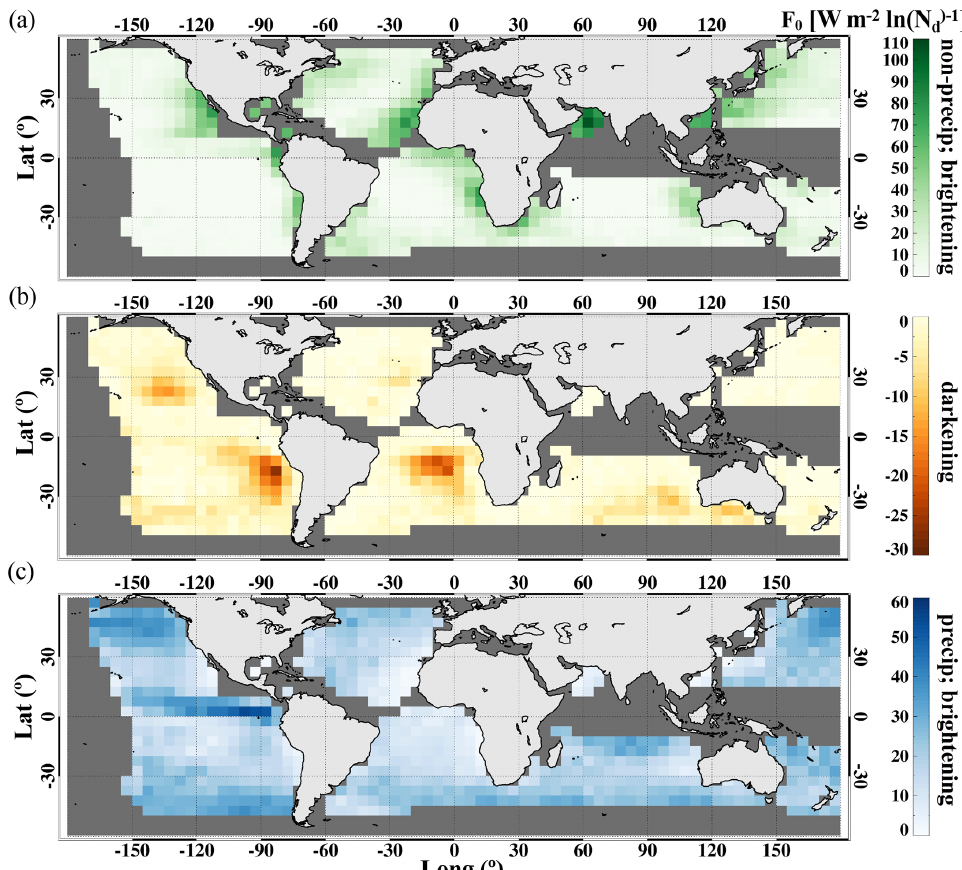
Figure 4. As in Fig. 3 but showing radiative susceptibility ( F 0 ).